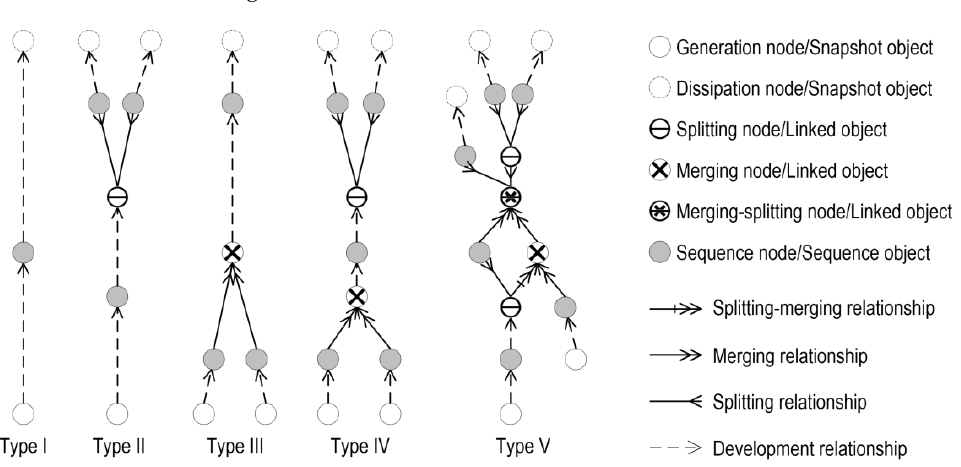
Figure 6. Evolutionary structural types of ocean dynamics. Circles represent sequence objects, linked objects, or marine snapshot objects; arrows represent one of four evolutionary relationships.